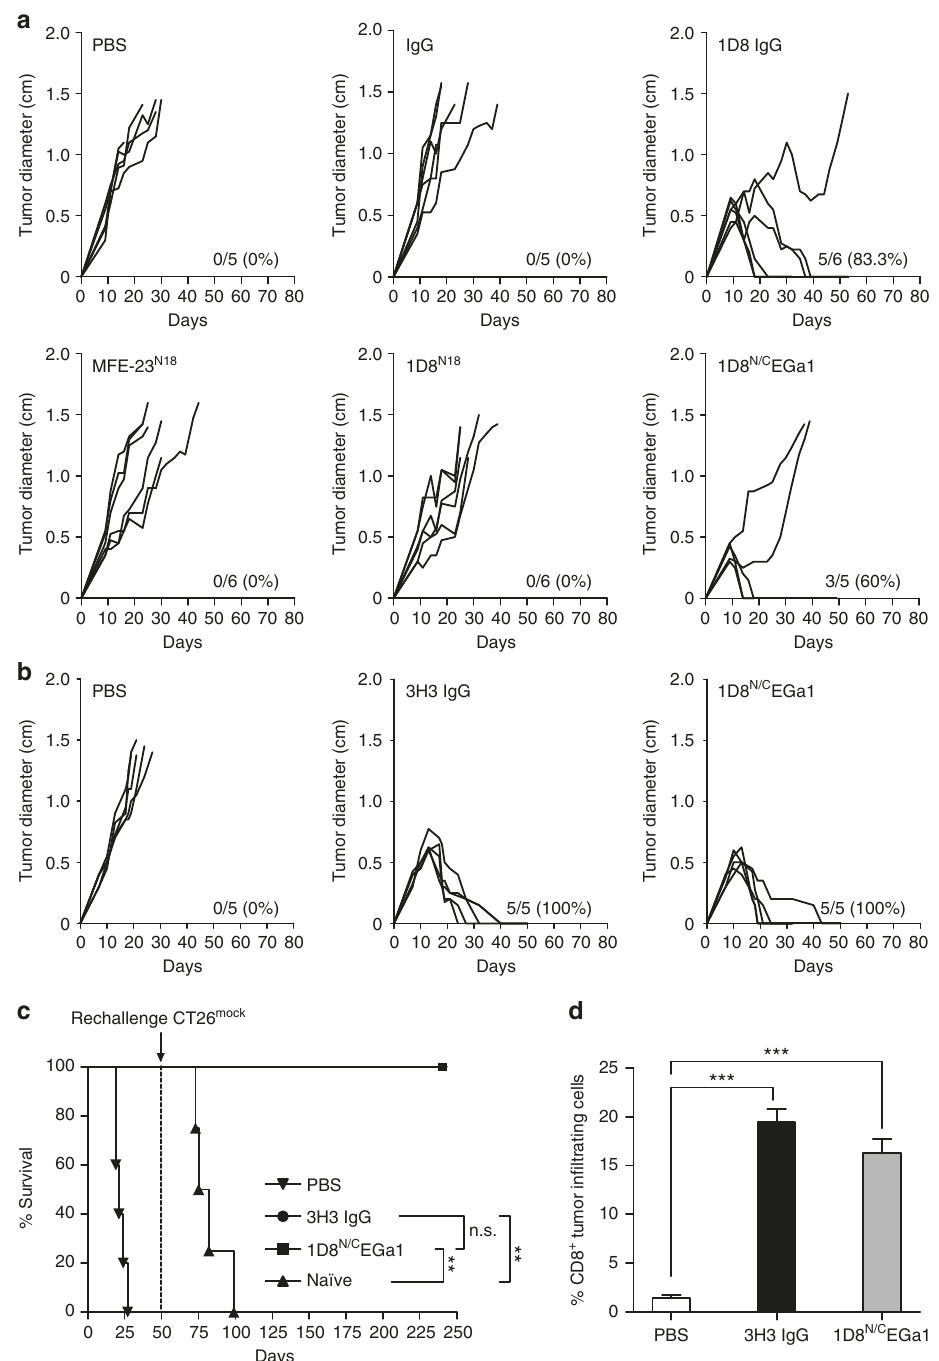
Fig. 5 Induction of tumor regression in mice treated with 1D8 N/C EGa1 trimerbody. a BALB/c mice inoculated s.c. with CT26 hEGFR tumor cells ( n = 6/group) were treated with three i.p. doses (4 mg/kg) of rat IgG 2a isotype, 1D8 IgG, MFE-23 N18 , 1D8 N18 , 1D8 N/C EGa1, or with PBS and monitored for tumor growth. Tumor diameter growth curves for individual mice in each treatment group are presented. The results are representative of two experiments identically performed. b BALB/c mice bearing CT26 hEGFR tumors ( n = 5/group) were treated with three i.p. doses of either PBS, 3H3 IgG, or 1D8 N/C EGa1. c Kaplan – Meier survival curves of the 1D8 N/C EGa1 trimerbody-treated mice (** P ≤ 0.01), log-rank (Mantel – Cox) test. Long-term survivors, following complete tumor rejection ( b ) were rechallenged with CT26 mock cells (s.c.) 50 days after i.p. injections of 3H3 IgG or 1D8 N/C EGa1 trimerbody. As a control group, tumor naive mice developed tumors in every case. d Quantitative analysis of intratumoral CD8 + T cells in paraf fi n - embedded mouse tumor tissue ( n = 3/group) by immunohistochemistry. Data were calculated as percentage of CD8 + versus total cell number and presented as mean ± SD. *** P ≤ 0.001, Student's t